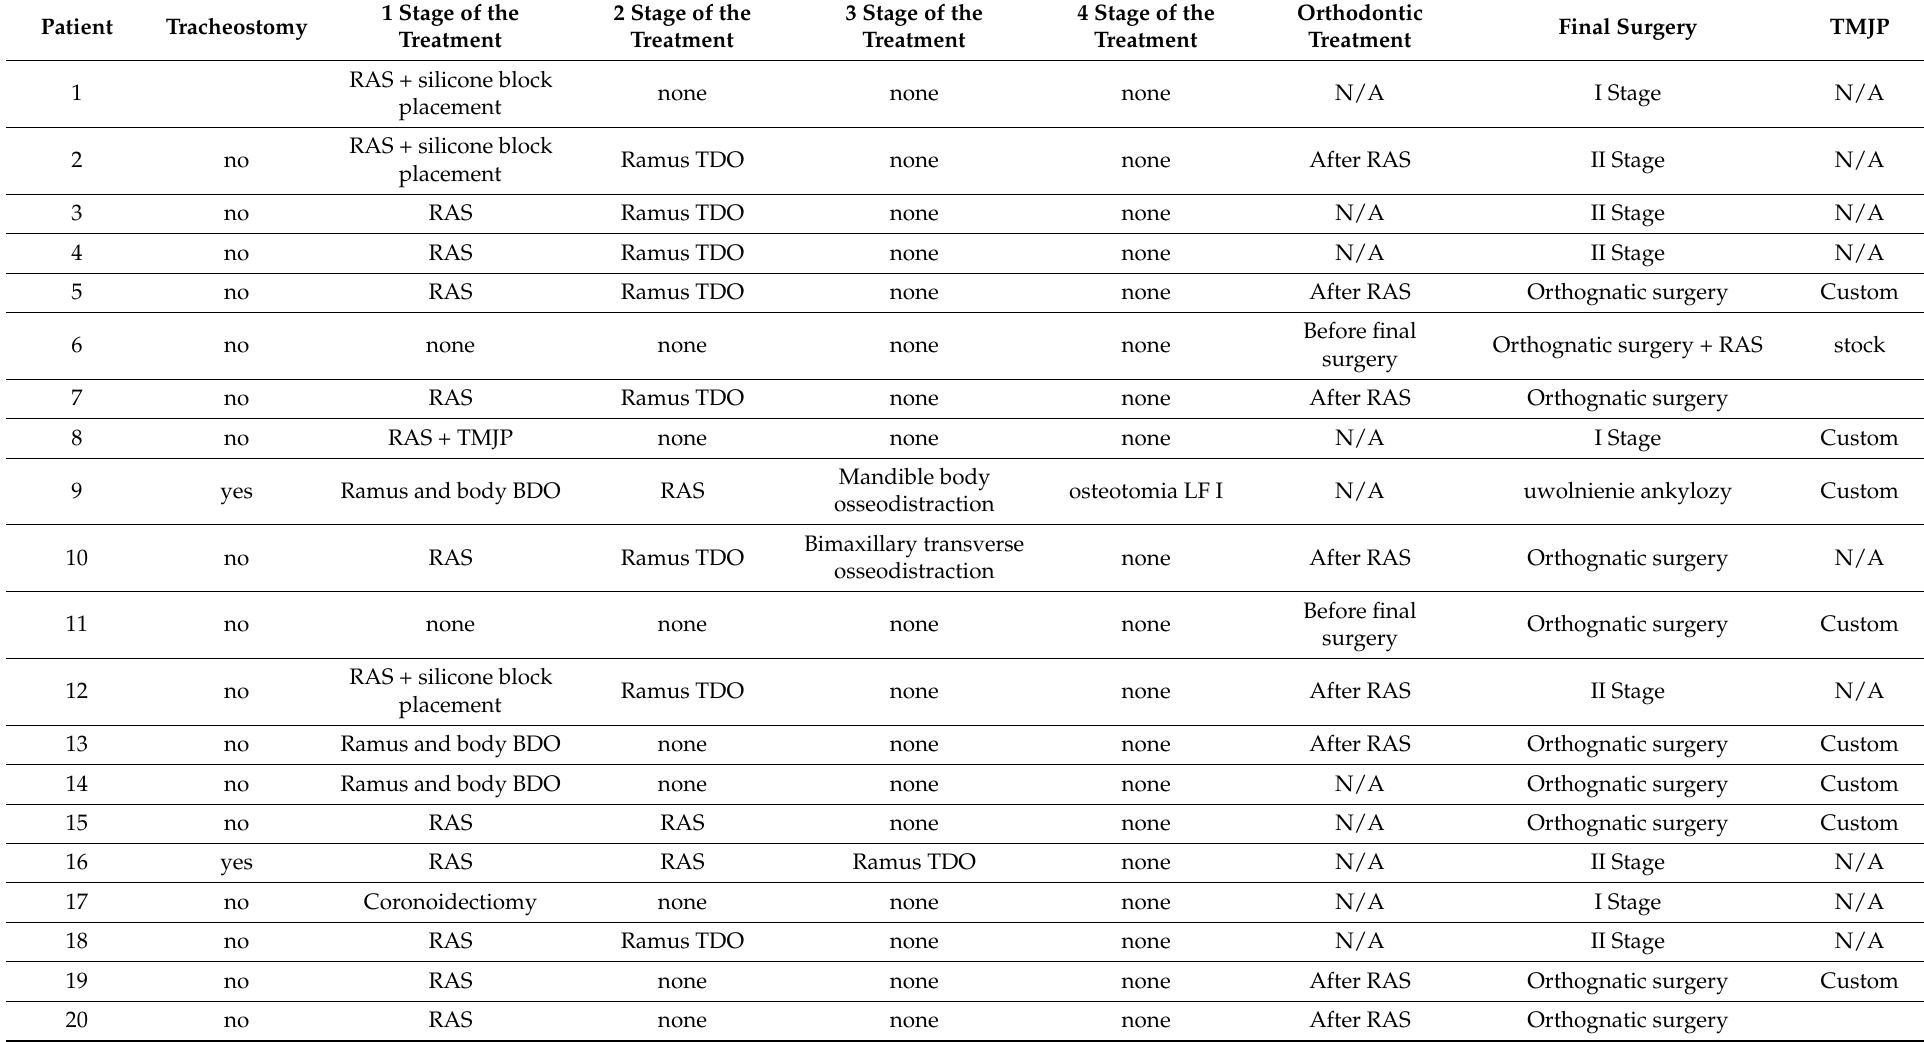
Table 2. Characteristics of the enrolled cohort and types of procedures performed depending on the age